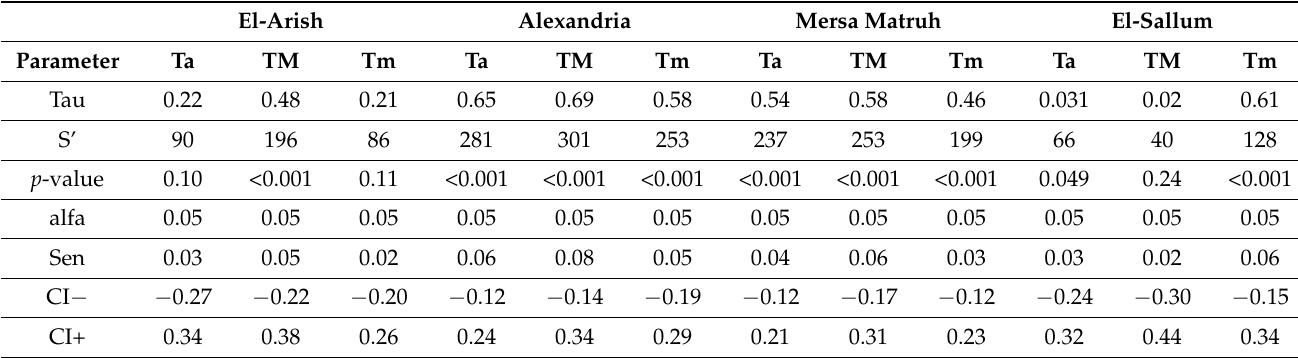
Table 4. Results of Mann–Kendall test for all weather stations at annual scale from 1991 to 2020 in El Arish, Alexandria, Mersa Matruh, and El-Sallum.